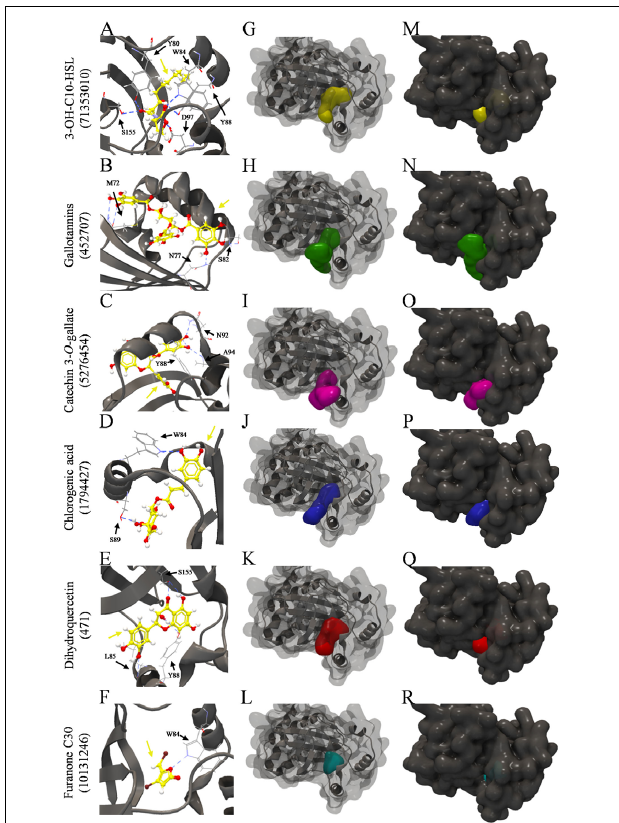
FIGURE 5 | Molecular docking of 3QP8 structure of CviR protein of C. violaceum ATCC 12472 with 3-OH-C10-HSL, gallotannins, catechin 3- O -gallate, chlorogenic acid, dihydroquercetin, and furarone C30. (A–F) Backbone representation of 3QP8 structure with hydrogen bond between the amino acid residues and evaluated compounds, (G–L) surface and backbone representations, and (M–R) surface representation. Gray surface representation, CviR; yellow surface representation, 3-OH-C10-HSL; green surface representation, gallotannins; pink surface representation, catechin 3- O -gallate; blue surface representation, chlorogenic acid; red surface representation, dihydroquercetin; cyan surface representation, furarone C30; gray backbone representation, CviR; black arrow indicates the binding site; yellow arrow, 3-OH-C10-HSL or gallotannins or catechin 3- O -gallate or chlorogenic acid or dihydroquercetin or furarone C30; blue dashed line, hydrogen